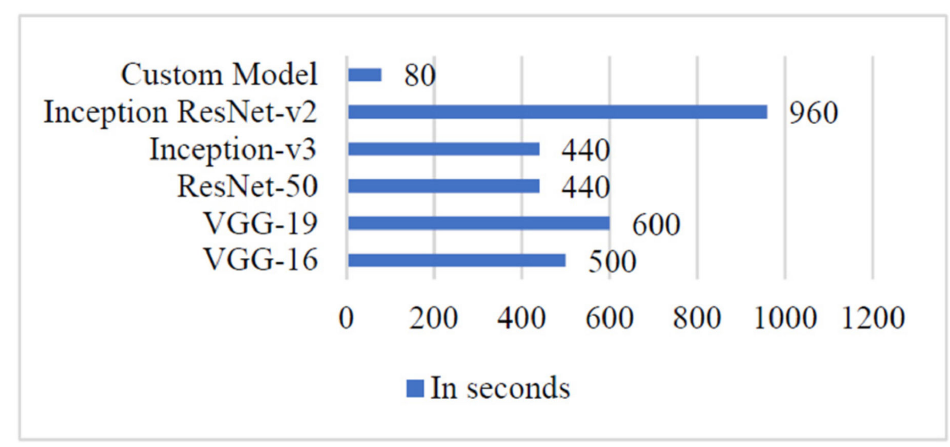
Figure 11. Training time of different deep learning models.